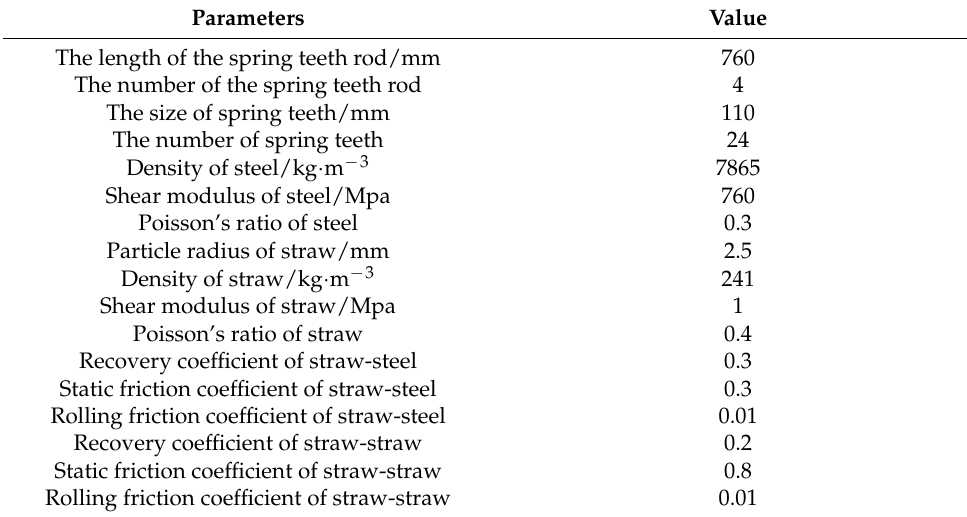
Table 2. Coupling simulation input